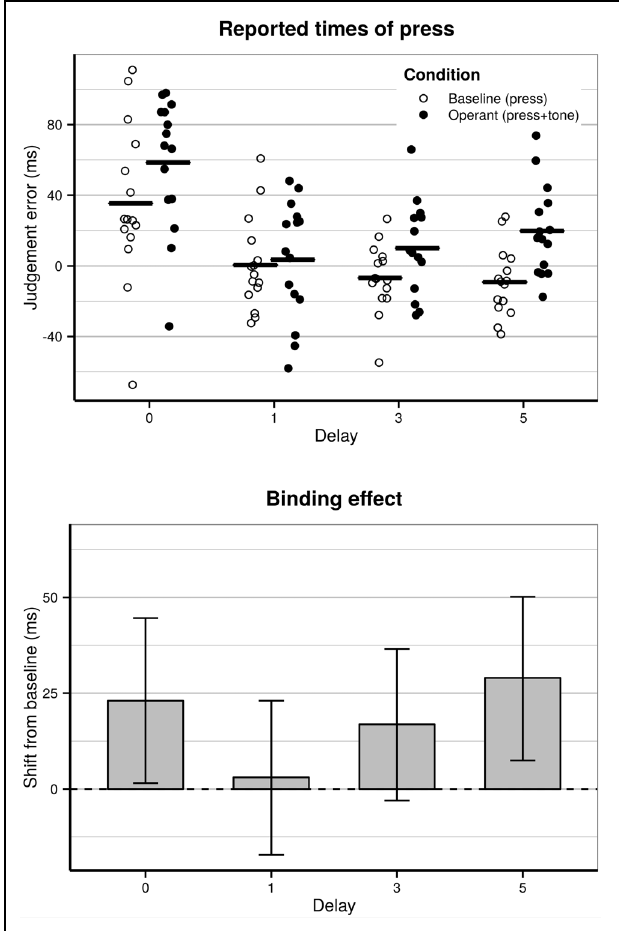
FIGURE 3 | (Top) Reported times of action relative to the actual occurrence of action, across delays for the baseline and the operant conditions. The dots show the estimates for each participant, and the solid bars show the group level times. (Bottom) Group level estimated binding effect for press. Error-bars indicate 95% confidence intervals of the estimated effects based on posterior simulation of the full model ( n = 10000).